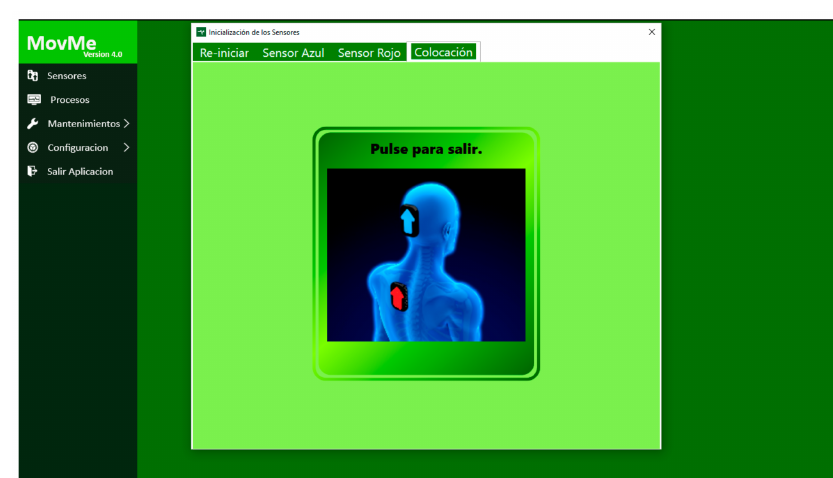
Figure 1. Inertial motion units and EBI-5 (estudio biomec á nico integral) system.